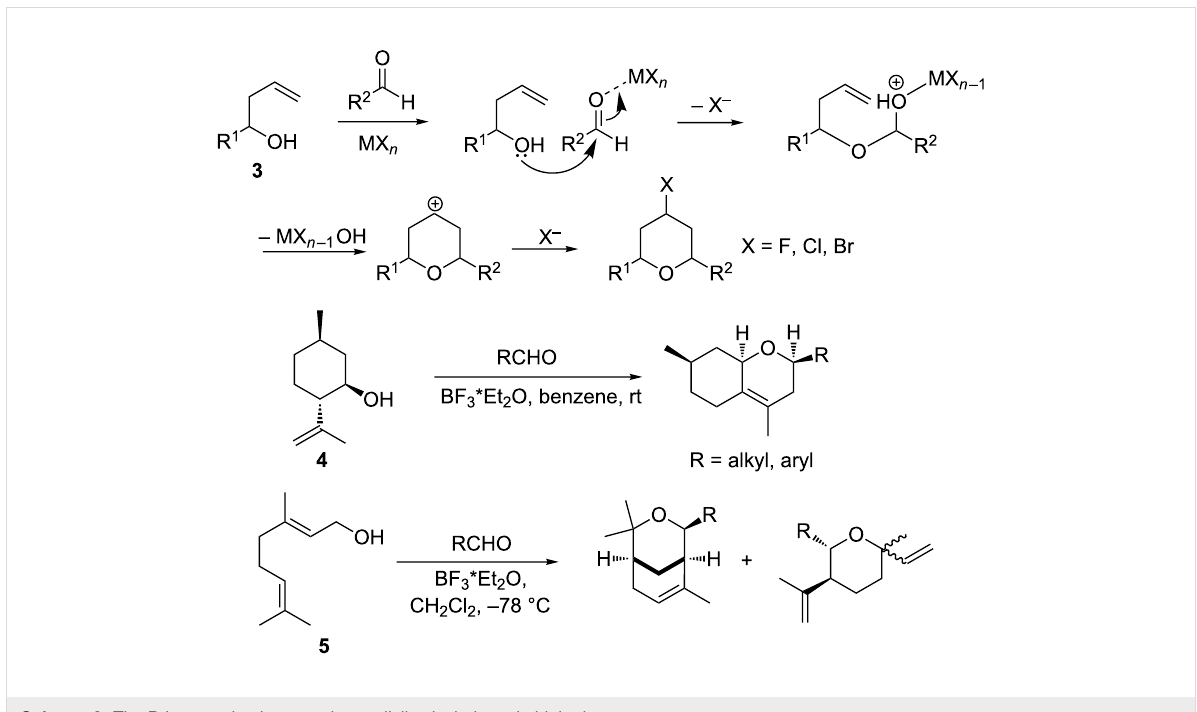
Scheme 2: The Prins reaction between homoallylic alcohols and